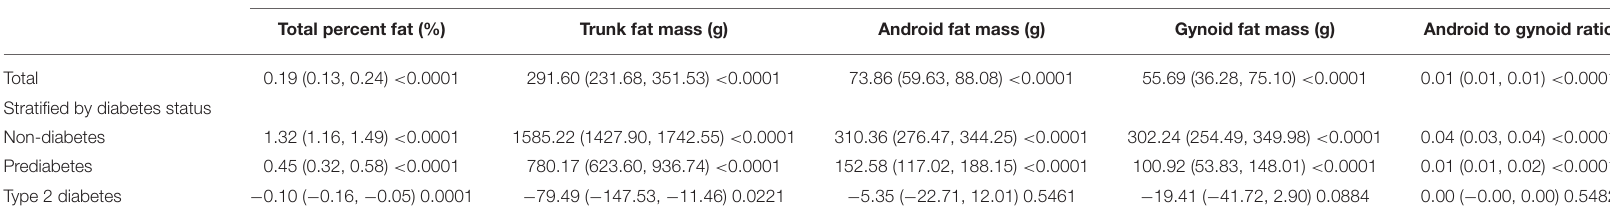
TABLE 3 | Associations of serum glucose (mmol/L) with adipoity.